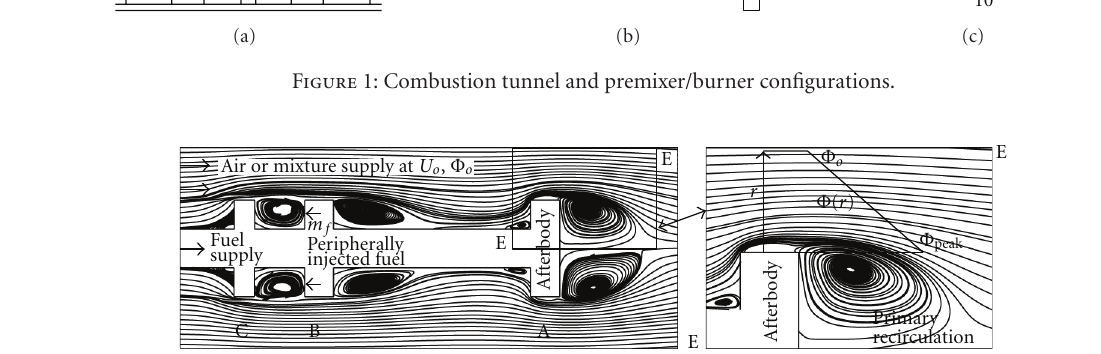
Figure 2: Fuel, air flows, and mixture placement at flame stabilizer inlet.